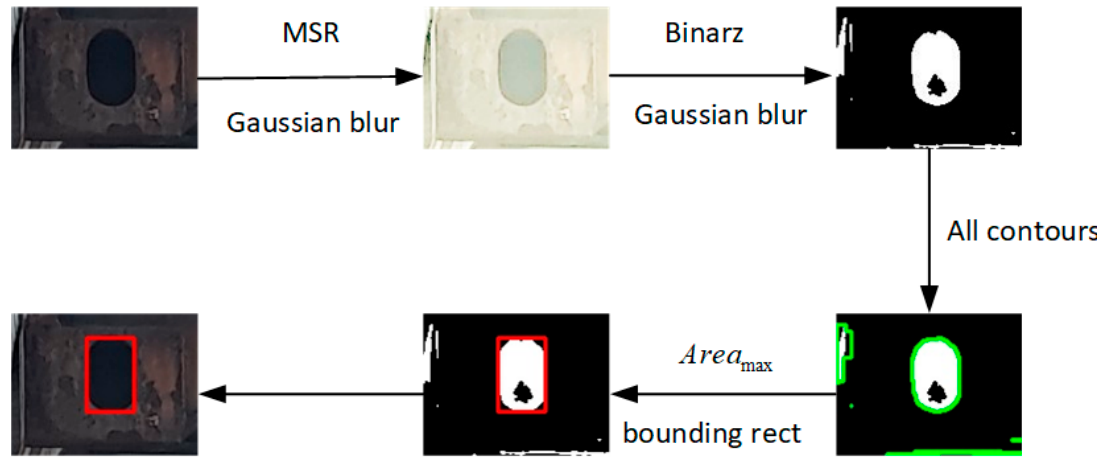
Figure 7. Secondary location algorithm.